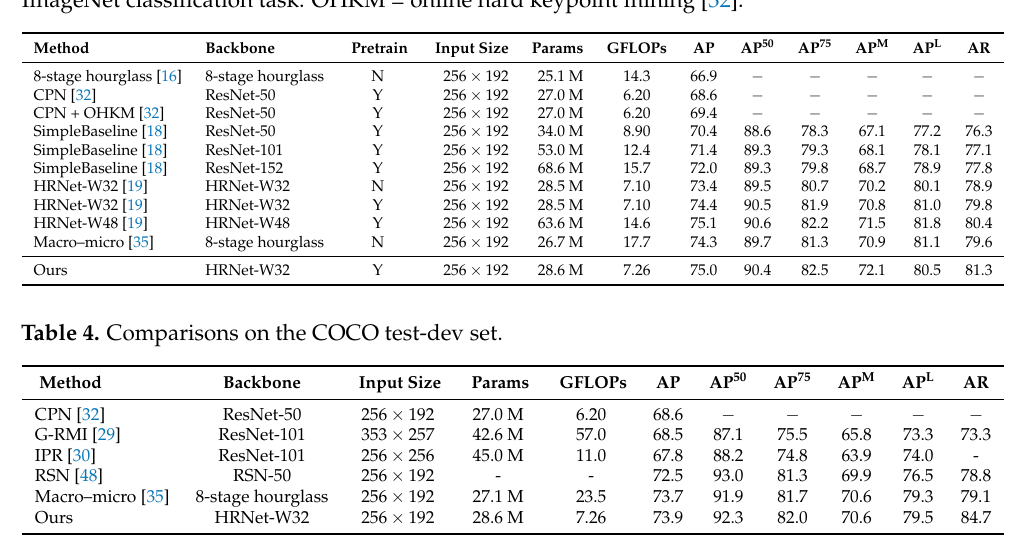
Table 3. Comparisons on the COCO validation set. Pretrain = pretraining the backbone on the ImageNet classification task. OHKM = online hard keypoint mining [32].